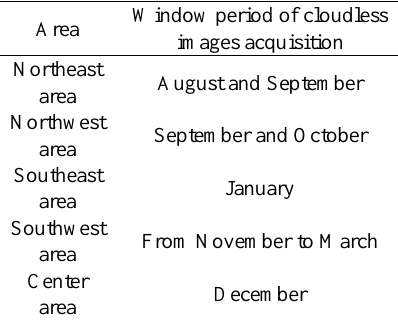
Table 2. The Window period of cloudless images acquisition for different areas in